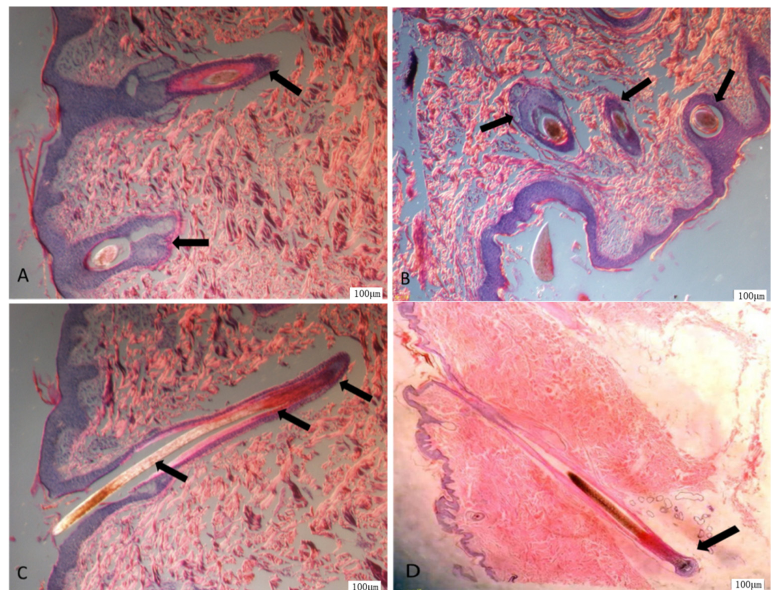
Figure 3. Hematoxylin and eosin staining of hair follicles in Min pigs in winter (December). Villous hair follicles: ( A ) The arrow refers to outer root sheath cells. ( B ) The arrow refers to multiple growth periods of villous hair follicles. ( C ) The arrow refers to the hair follicle with a complete structure, including an outer root sheath, an inner root sheath, and the hair stem. Bristle hair follicle. ( D ) The arrow refers to the spherical hair follicle.